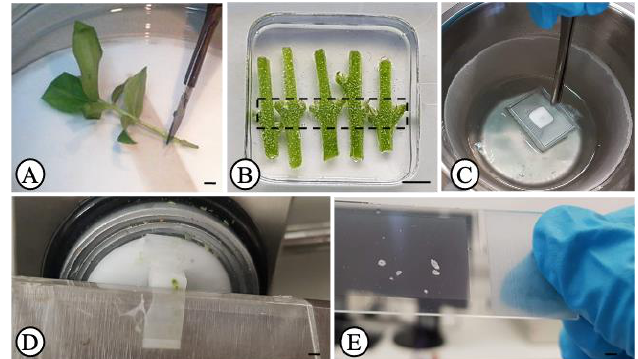
Figure 1. Plant material preparation for laser microdissection. ( A ) olive microcutting showing the cutting site of the stem nodal segment; ( B ) stem nodal segments in cryomolds containing OCT medium; ( C ) cryomolds containing the segments being frozen in liquid nitrogen-cooled isopen- tane; ( D ) cryosectioning; ( E ) cryosections on a PEN-membrane glass slide after dehydration and drying. Scale bars, 4 mm.